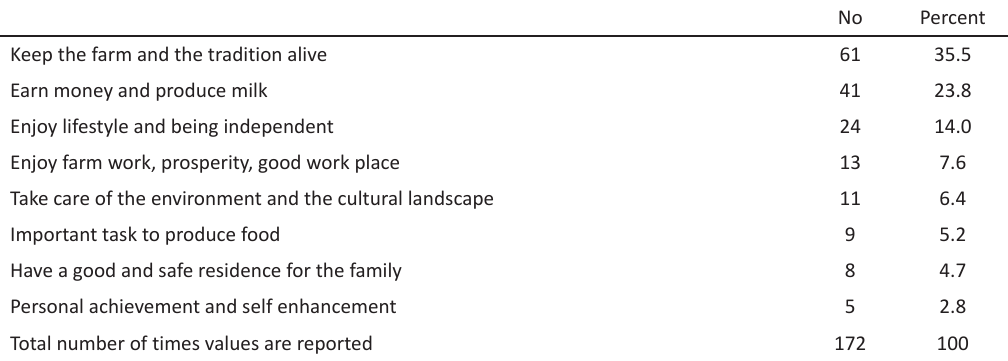
Table 5. Number of times the farmers report the different